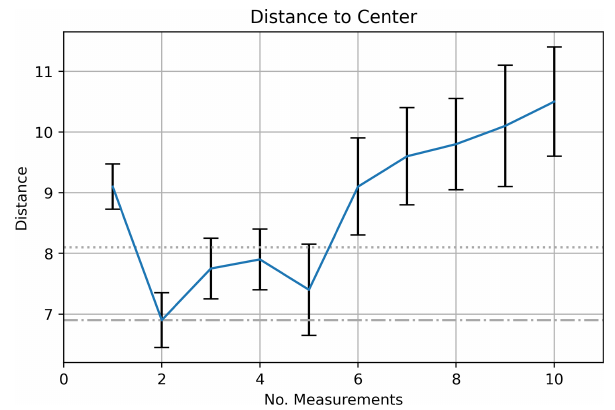
Figure 20. Single-body, variable-location standard deviation ratios. The plot shows the mean standard deviation ratio after a given num- ber of measurements taken under each tested method. The mean ratio is shown along with 1 standard error bounds for each